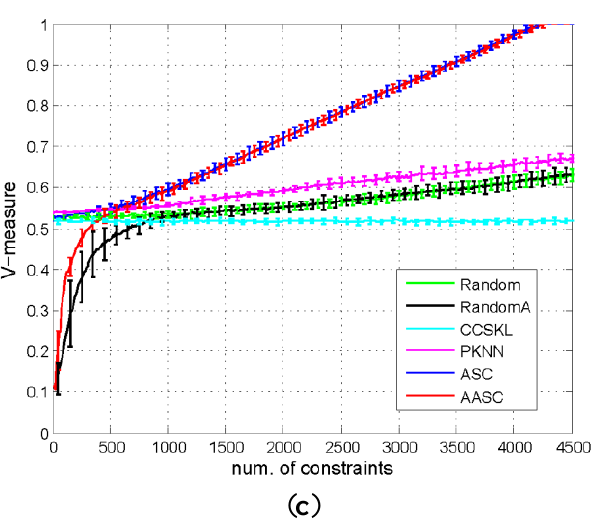
Figure 10. Clustering accuracy as evaluated using the V-measure. We ran each algorithm 50 times, and the results are shown as the means and standard deviations of the V-measure: